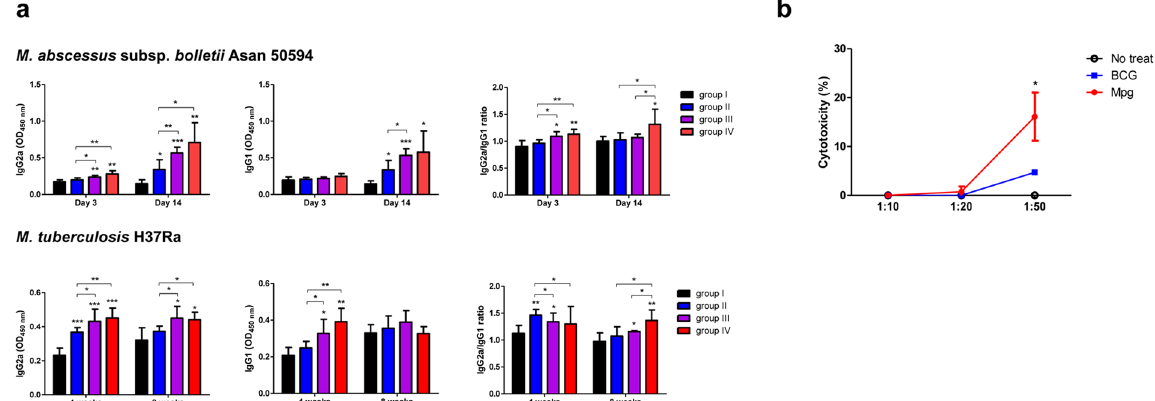
Figure 7. M. paragordonae (Mpg) elicits an enhanced mycobacterial-specific Th1-biased humoral response and cytotoxic T lymphocyte (CTL) response in immunized mice. ( a ) Mab- and Mtb-specific immunoglobulin subtypes (IgG2a and IgG1) were detected by ELISA from serum samples of vaccinated and challenged mice. Optical densities at 450 nm of IgG2a and IgG1 isotypes were detected and compared among all the vaccinated groups at each time point. The ratio of IgG2a/IgG1 was calculated by dividing the OD values for IgG2a by OD values for IgG1 ( * P < 0.05, ** P < 0.01, *** P < 0.001; Student’s t -test). ( b ) Splenocytes from BCG- or Mpg- immunized mice were stimulated with Ag85B protein for 6 days and used as effector cells. P815 cells (H-2 d ) were transfected with pcDNA 3.3-Ag85B:ESAT-6 expression vector and used as target cells. CTL assay was conducted by co-culturing the target and effector cells at various ratio (E/T ratios of 10:1, 20:1, and 50:1). Supernatants of co-cultured cells were used for lactate dehydrogenase (LDH) cytotoxicity assay ( * P < 0.05; Student’s t -test). Each vaccinated group is annotated as follows: group I [PBS + PBS], group II [BCG + BCG], group III [BCG + Mpg], and group IV [Mpg +